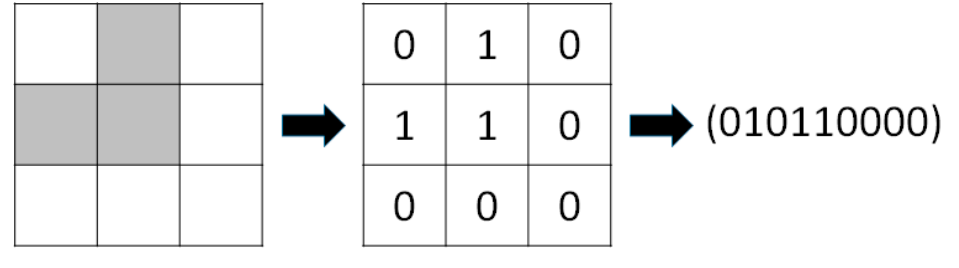
Figure 3. Binary coding.